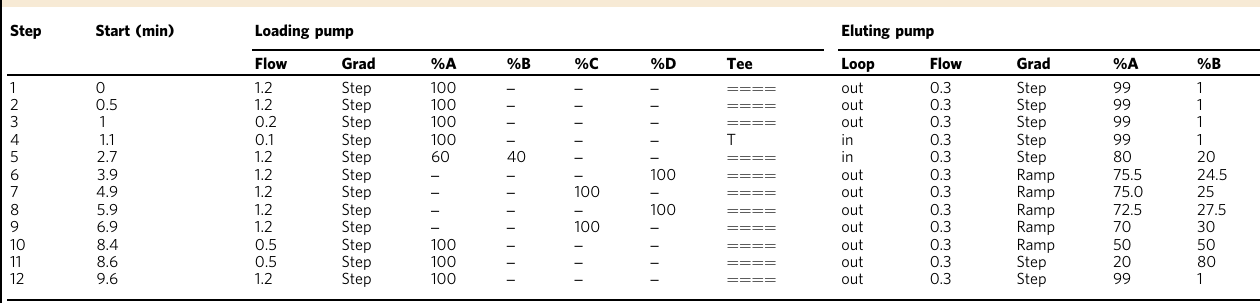
Table 2 Conditions for turbulent fl ow chromatography (TFC) loading and eluting pumps for analysis of SARS-CoV-2 nucleoprotein target peptides.